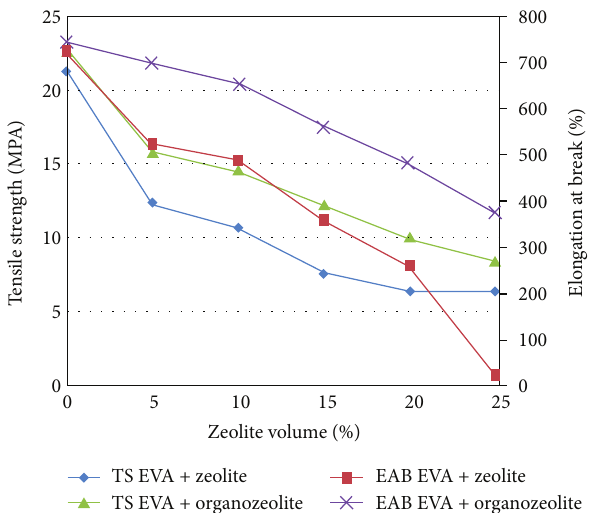
Table1:Weightpercentagesofoccurrenceelementsinzeolitebefore